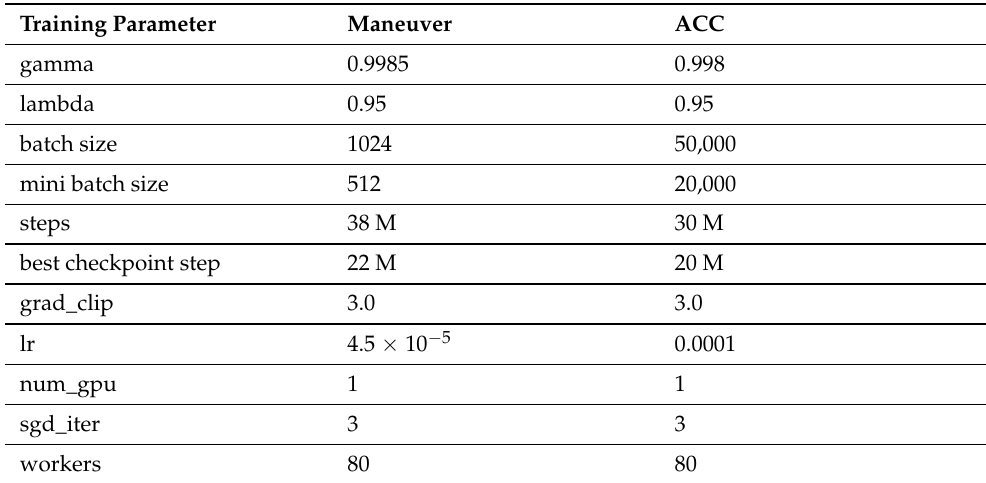
Figure 2. The graph shows the accumulated average sum of rewards (Maneuver Agent - Orange and ACC Agent - Blue) during the episodes between optimization steps. The training typically achieves its best performance at some point and then after more iterations either keeps the performance or degrades it. Then to get the best agent we choose the checkpoint with the highest mean sum of rewards (22M step for the Maneuver agent and 20M step for the ACC agent). The difference between the reward levels is due to the different definitions of the reward function. Table 2. Table includes major hyperparameters of PPO algorithm used for training ACC and Maneu- ver agents. The trainings were performed with the usage of RLlib